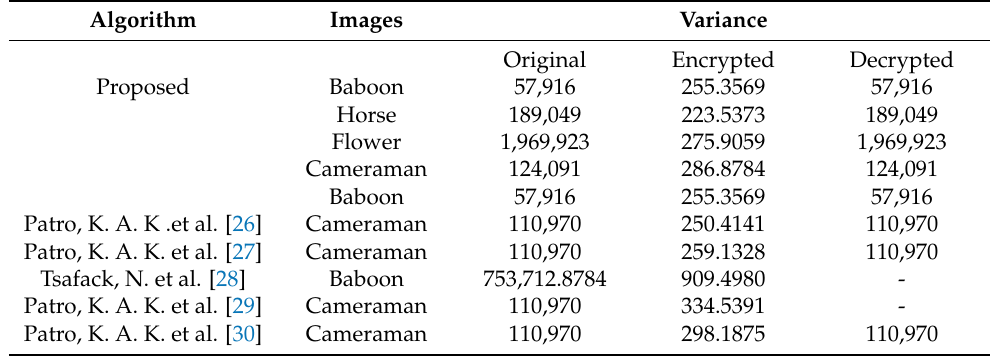
Table 3. Variance comparison